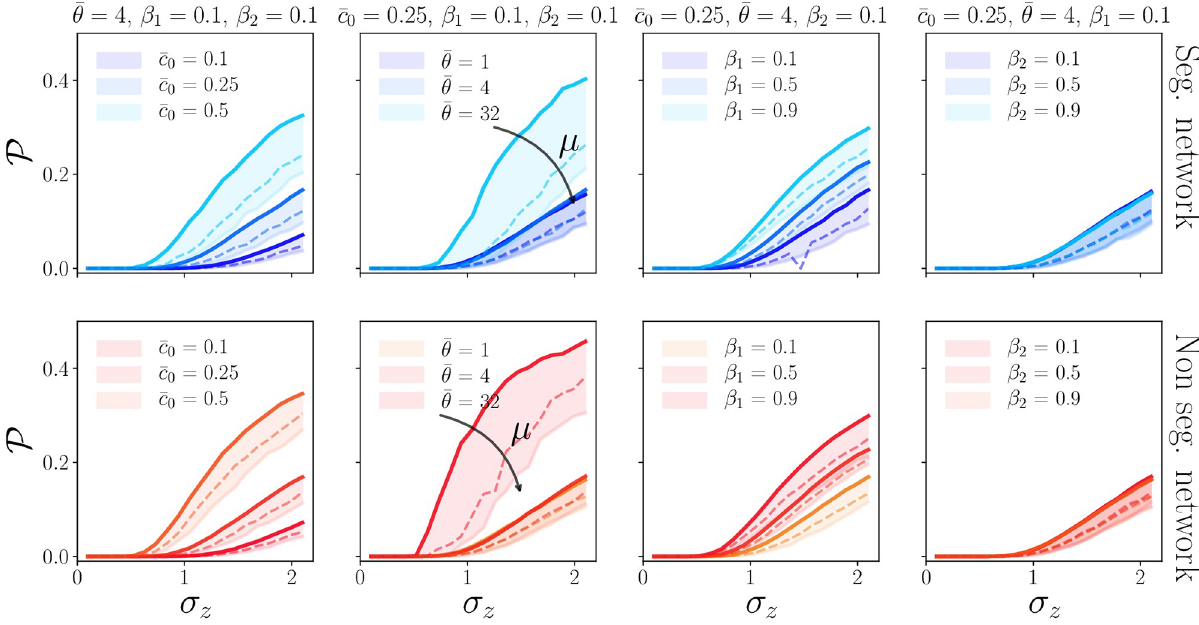
Fig 4. The panels show the probability of a global crisis P as a function of the exogenous shock amplitude σ 2 [0.1, 2.1]. We restrict the analysis to three values of μ : 0.2, 1.0 and 1.8. In each panel the intensity of the colour reflects the income inequality μ as in Fig 3. In each graph the global colour represents the level of segregation: when blue λ = 0.01, when red λ = 100. We study the dependence of P on four parameters: in each couple of graphs (segregated and non segregated network) we let one parameter between � c , β 1 , � y and β 2 vary and we keep the other three constants. When kept 0 ¼ 0 : 25 , � y ¼ 4 and β 1 = β 2 = 0.1. The varying parameter is represented with different line style, constants the parameters take the following values: � c 0 and the legend is shown within each panel.